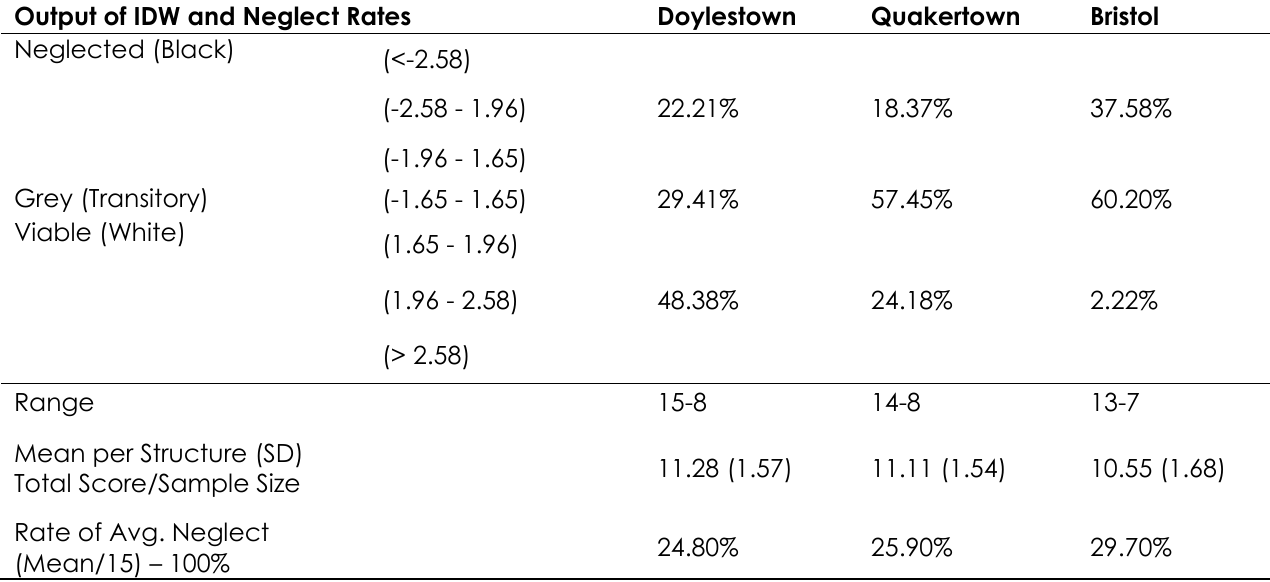
Table 6. Output of IDW and Neglect Rate Comparisons